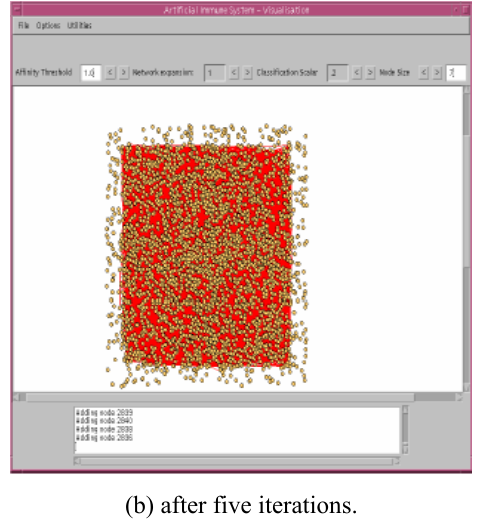
Figure 3. RLAIS-based clustering of Iris data set